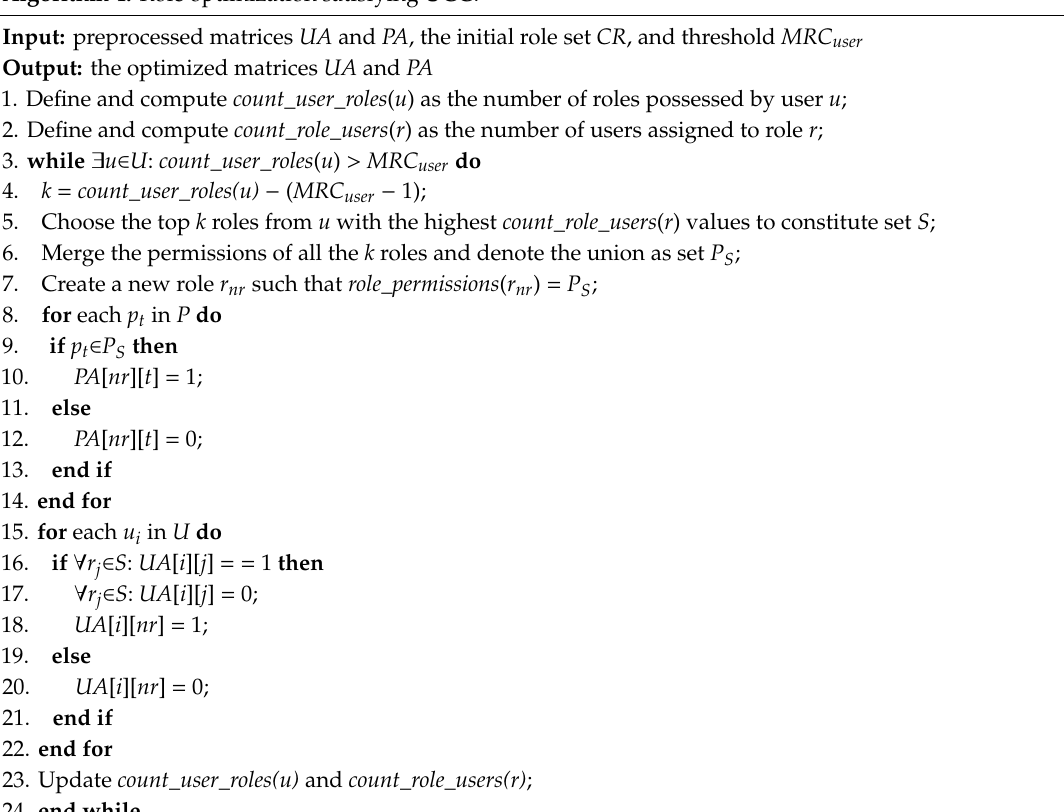
Algorithm 4. Role optimization satisfying